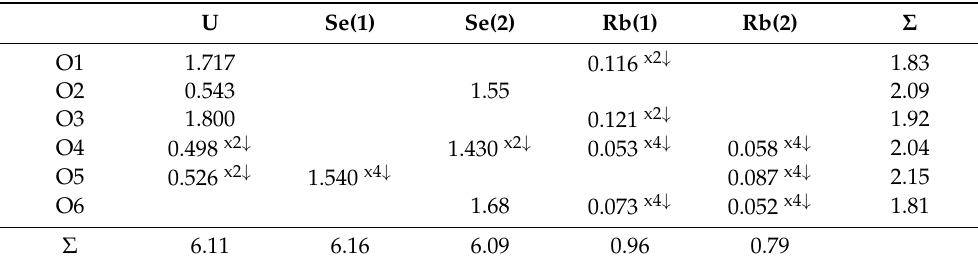
Table 2. BVS calculations for Rb 2 [(UO 2 ) 2 (SeO 4 ) 3